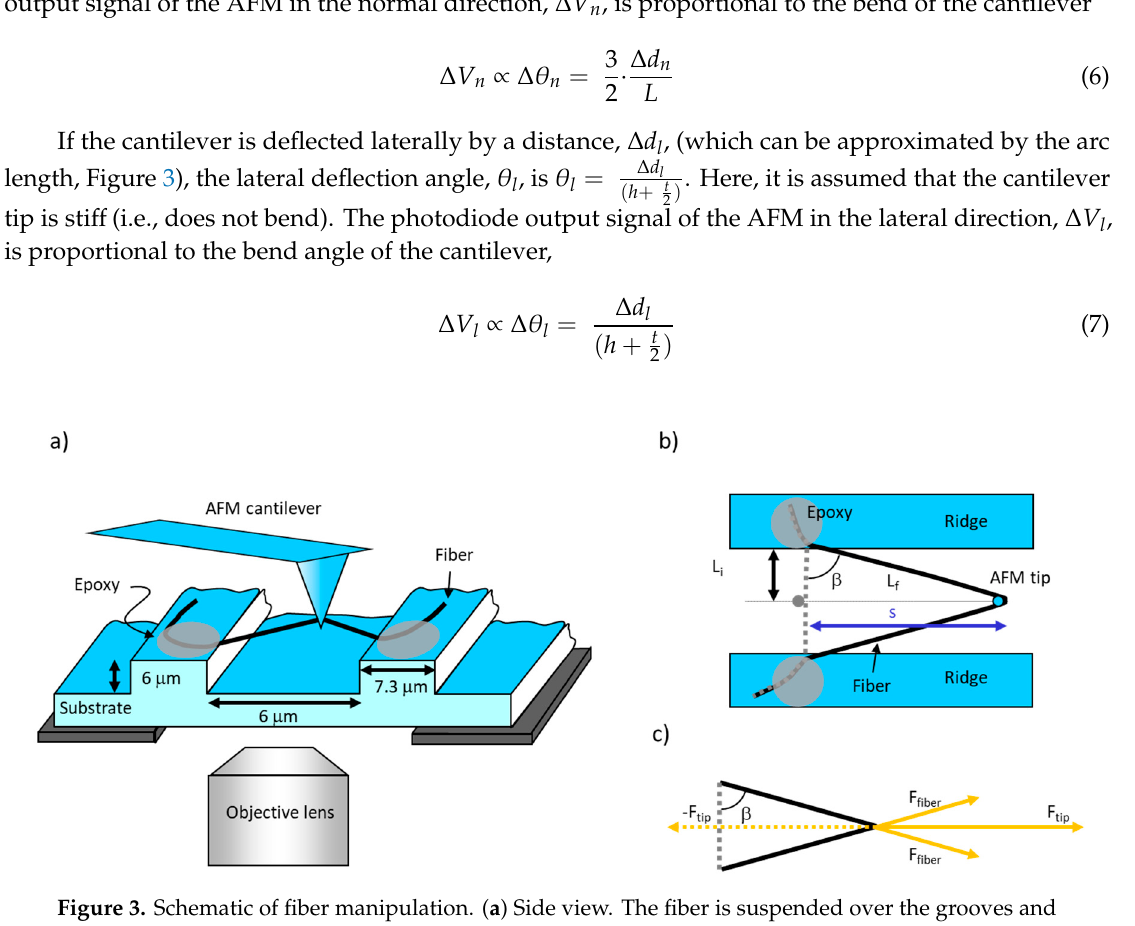
Figure 3. Schematic of fiber manipulation. ( a ) Side view. The fiber is suspended over the grooves and pulled by the laterally moving AFM probe. The fiber is anchored to the ridges by epoxy (gray ellipses). The fiber can be viewed by the inverted microscope beneath the substrate. ( b ) Top view. L i is half of the initial full length of the fiber while L f is half of the stretched length, assuming the fiber is pulled in the middle. The angle between L i and L f is β , and s is the distance travelled by the AFM tip. Figure adapted from [31]. ( c ) Force diagram showing the force balance between the force applied by the tip on the fiber, F tip , and the force applied by the fiber on the tip, − F tip . These forces are equal and opposite according to Newton’s third law. F tip is the sum of the x-components of the two F fiber forces that are applied to the top and the bottom arm of the fiber. F fiber is applied along the length of the fiber. F tip is equal in magnitude to the lateral force measured by AFM, F l ; F fiber is the force that stretches the upper and lower arm of the fiber (assuming symmetric pulling in the middle of the fiber).